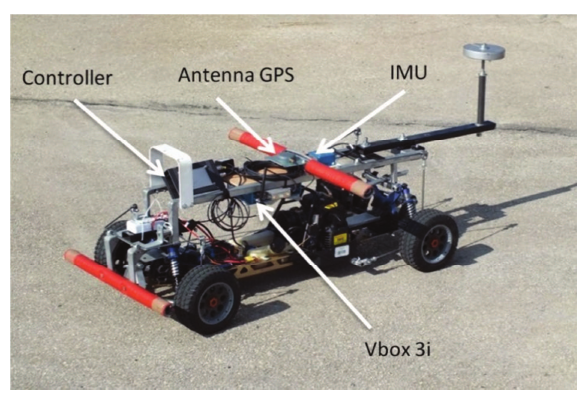
Fig. 10. The physical model of the vehicle on a scale ~1:5 with mounted measuring apparatus